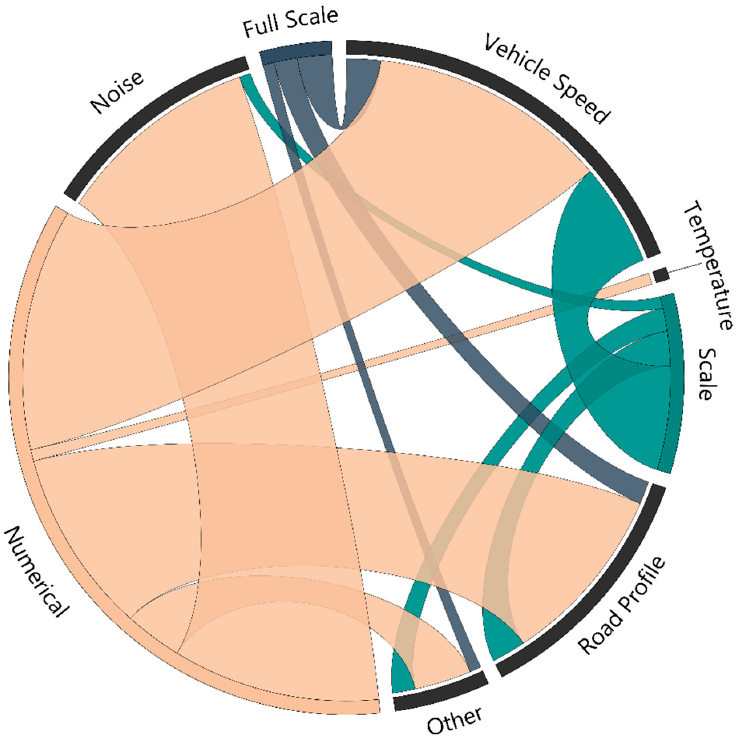
Figure 3. Interconnection between publication type and VBI sensitivity assessment.